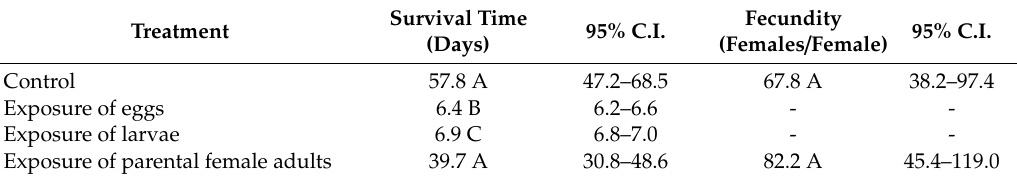
Figure 1. Survival curves of cohorts of Tribolium castaneum eggs, larvae, and progeny of parental female adults exposed to concrete treated with chlorfenapyr. The survival curves of the treatments followed by the same letter are not statistically different. Table 1. Mean survival times and fecundity (95% C.I.) of Tribolium castaneum